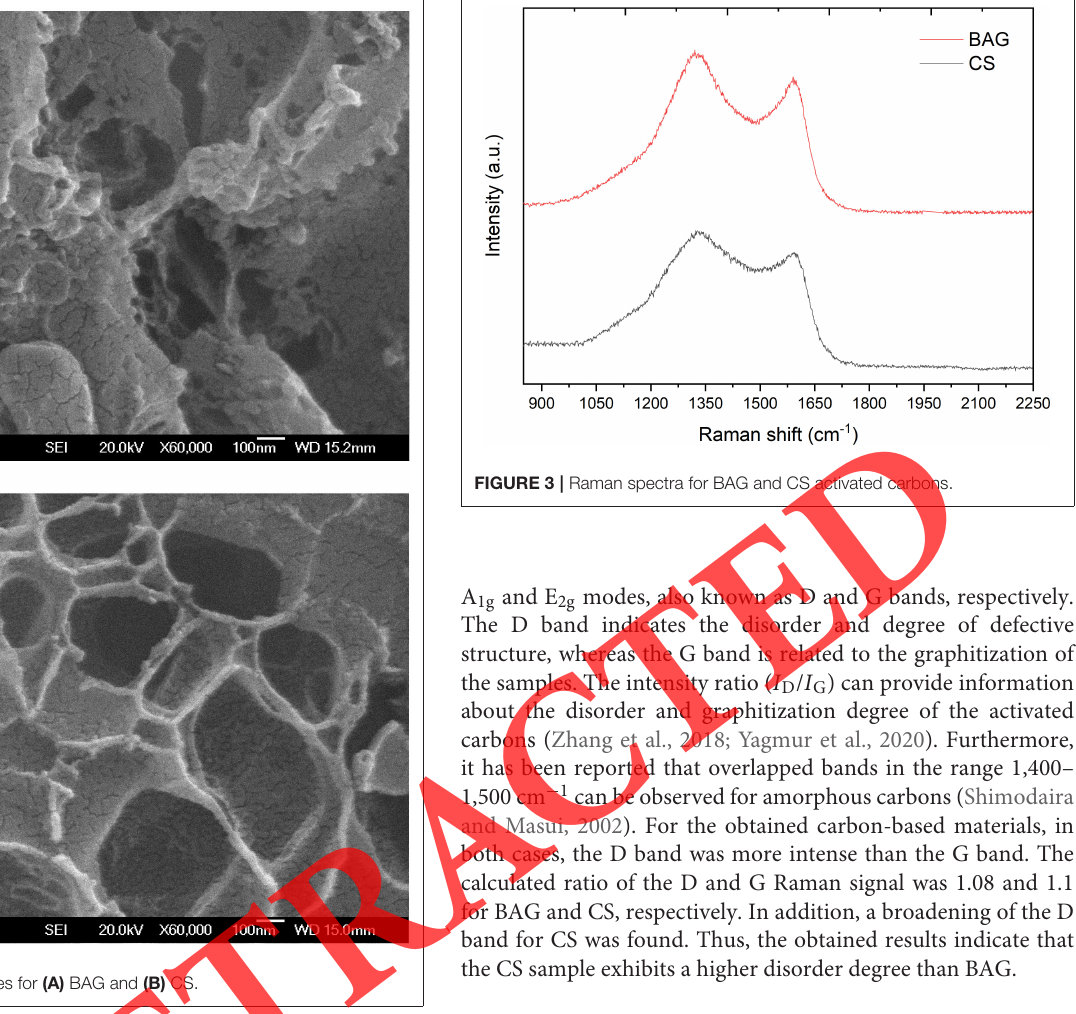
FIGURE 2 | SEM images for (A) BAG and (B) CS.